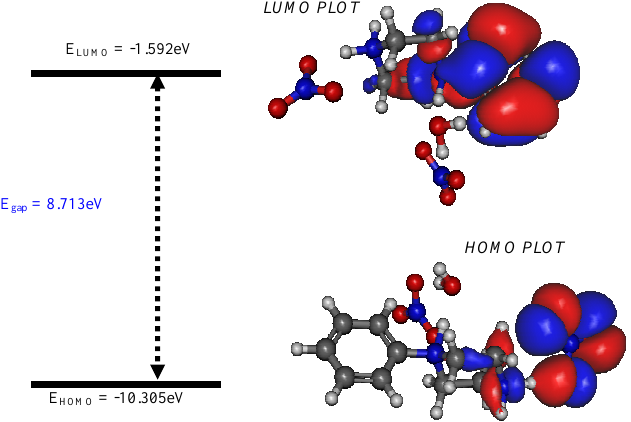
Figure 3. Calculated electrostatic potentials surfaces generated at an isodensity of 0.002 a.u. (a), (b) and (c) are different views of the isolated cation (C distribution over the molecule. Electrostatic potential surface energies range from +525.1 (red) to +1050.2 (blue) kJmol − 1 . Views (a’), (b’) and (c’) are for the phenylpiperazinium cation-two nitrate anions revealing the charge distribution at the surface of the compound. Water molecule was not considered in calculation in order to get better viewer of the charge repartition at the surface. Electrostatic potential surface energies range from − 157.7 (red) to +157.7 (blue) kJmol − 1 . (For interpretation of the references to color in this figure legend, the reader is referred to the web version of this article).